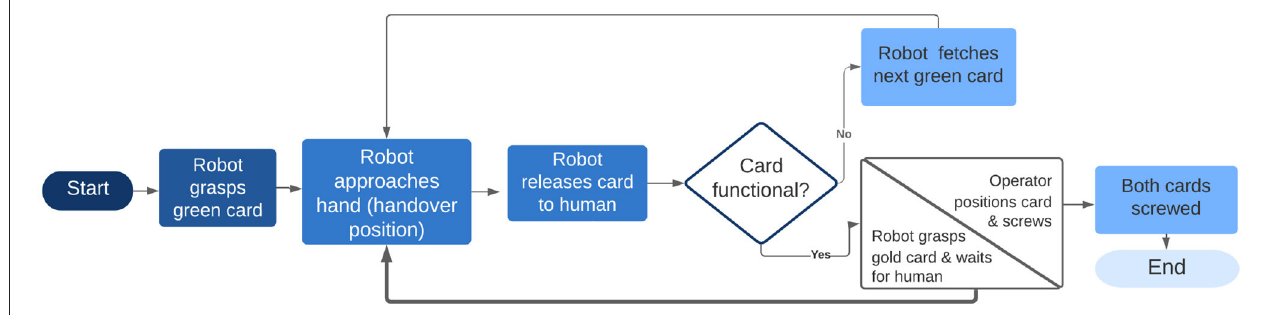
FIGURE 5 | Work-flow of the HRC